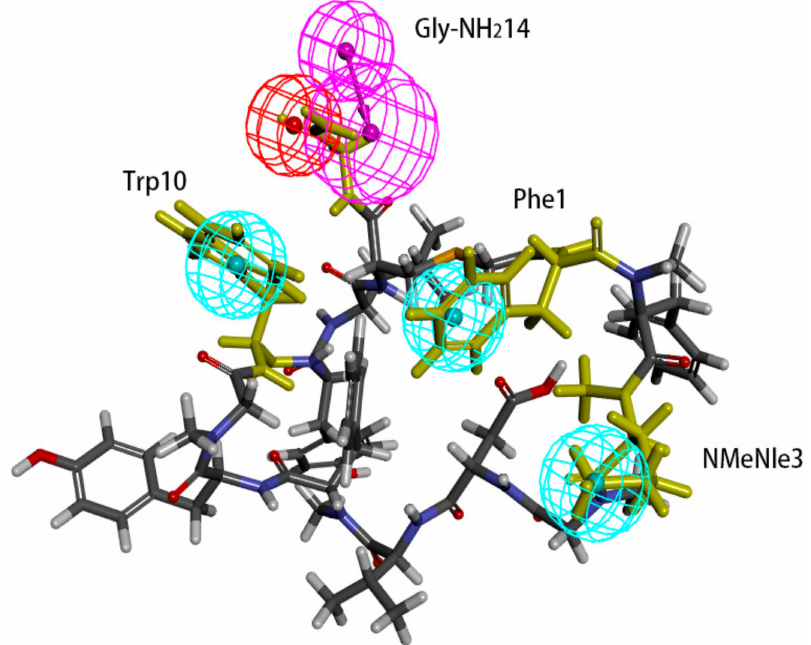
Figure 11. Superposition between Hypo 1B and peptide-71. As the figure shows, the positive ionizable point is red, the hydrophobic point is blue, and the hydrogen bond donor is purple. The labelled residues are